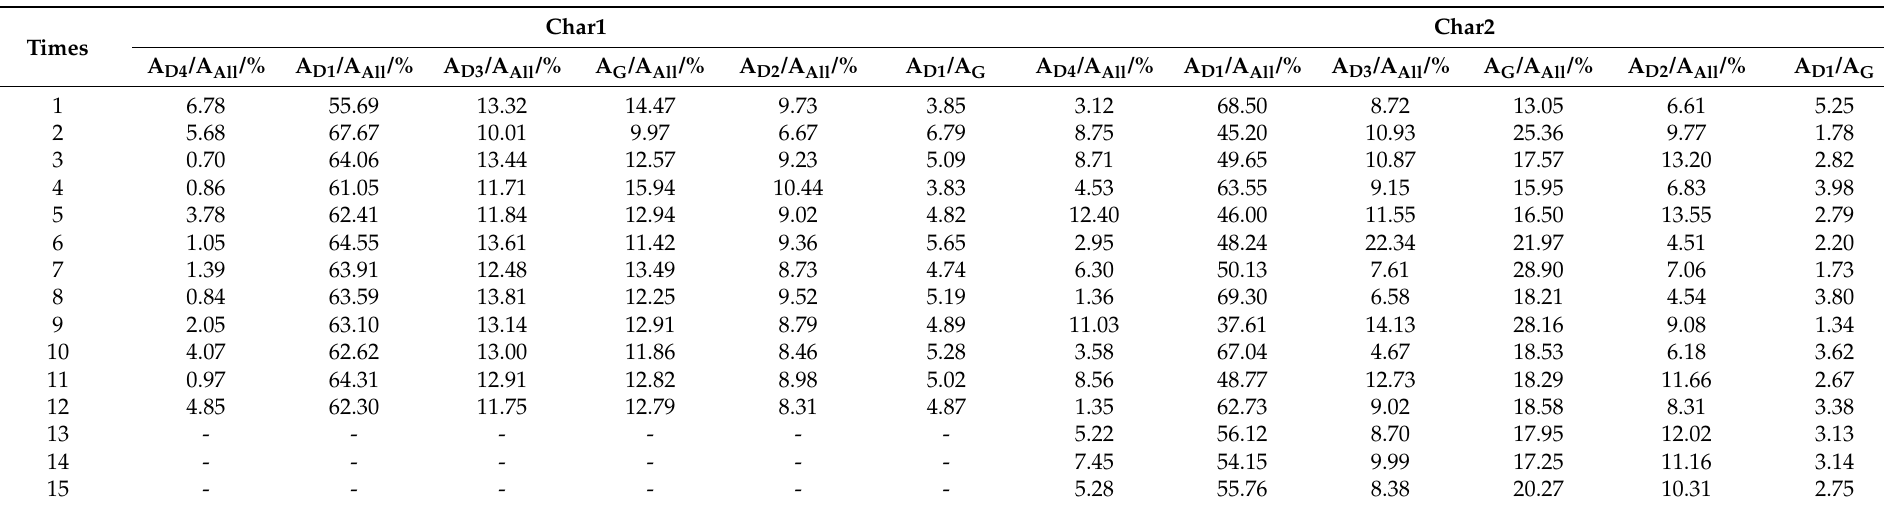
Table 5. Characteristic parameters obtained from multiple Raman measurements for char1 and char2 with a particle size of 61–75 µ